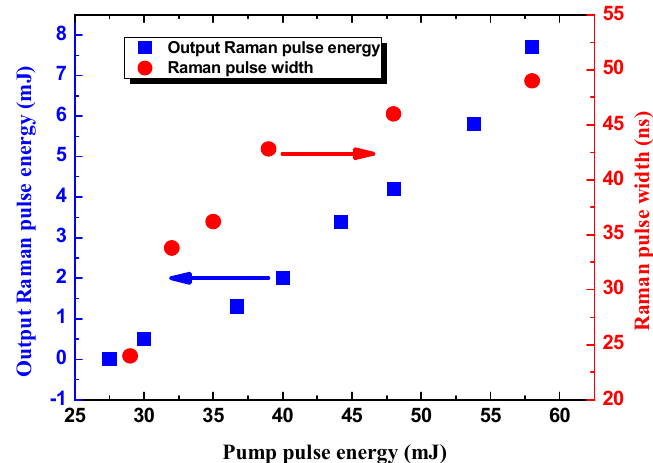
Figure 2. Output Raman pulse energy and pulse width versus the pump pulse energy.